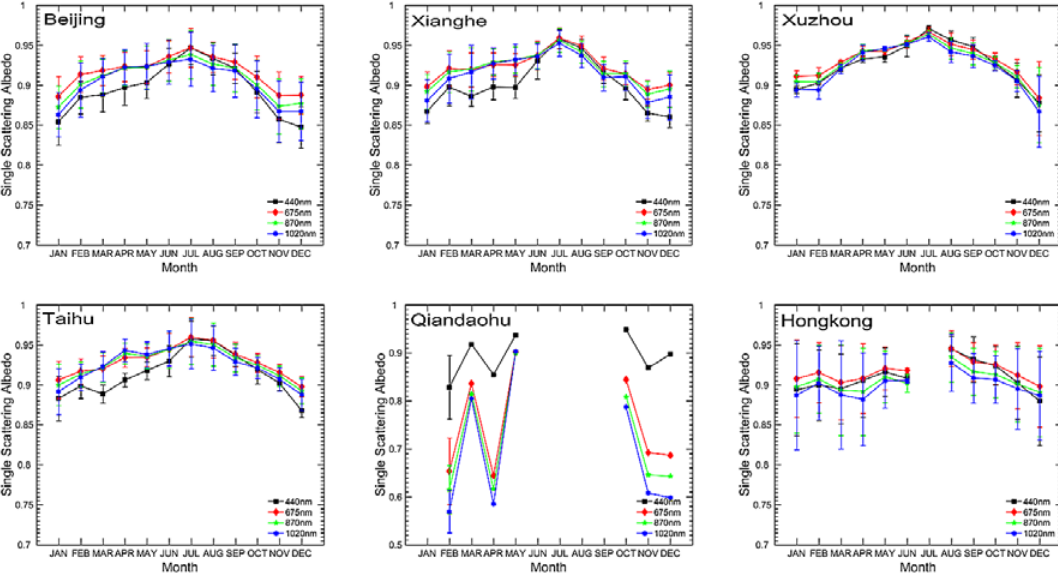
Figure 3. Monthly mean values of single scattering albedos in eastern China. The monthly values with available daily values of no more than 3 days every year were deleted.